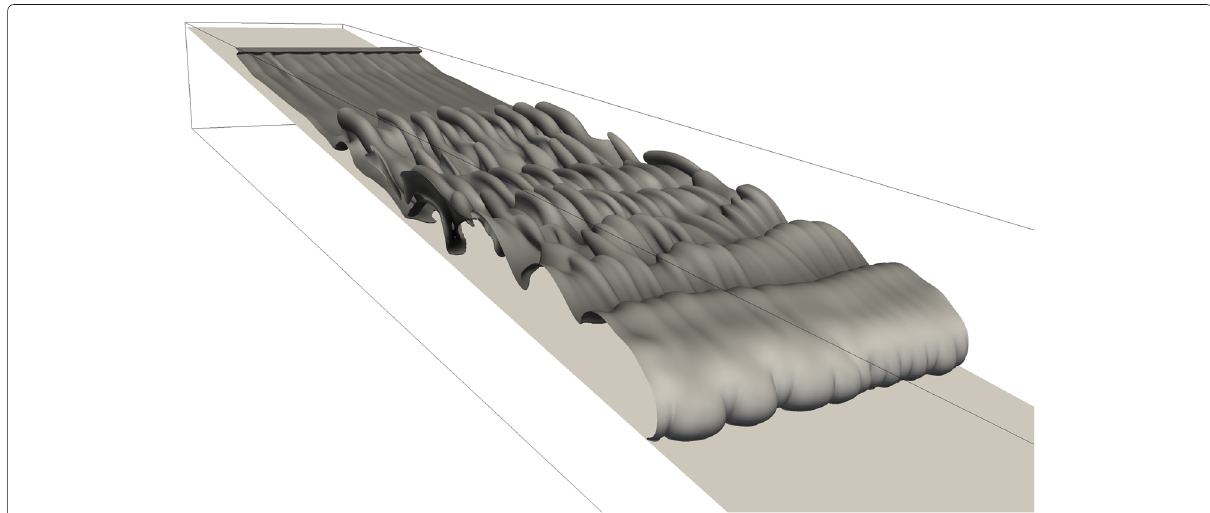
Fig. 3 Concentration isosurface c = 0.25 at t = 10 ( Re = 6000, v s = 0.005, N = 2.09, m = 0.0744). The iso-surface reveals the global structure of the envelope of a hyperpycnal current upon destibalization. The lobe-and-cleft instability is clearly visible at the head of the current as hills and crests form in the spanwise direction. This instability propagates in the body of the current and destabilises the large 2D vortical structures initially present. The largest wavelength corresponds to the initial dominant mode of the instability and dictates the width of the domain necessary to observe the instability at this given Reynolds number